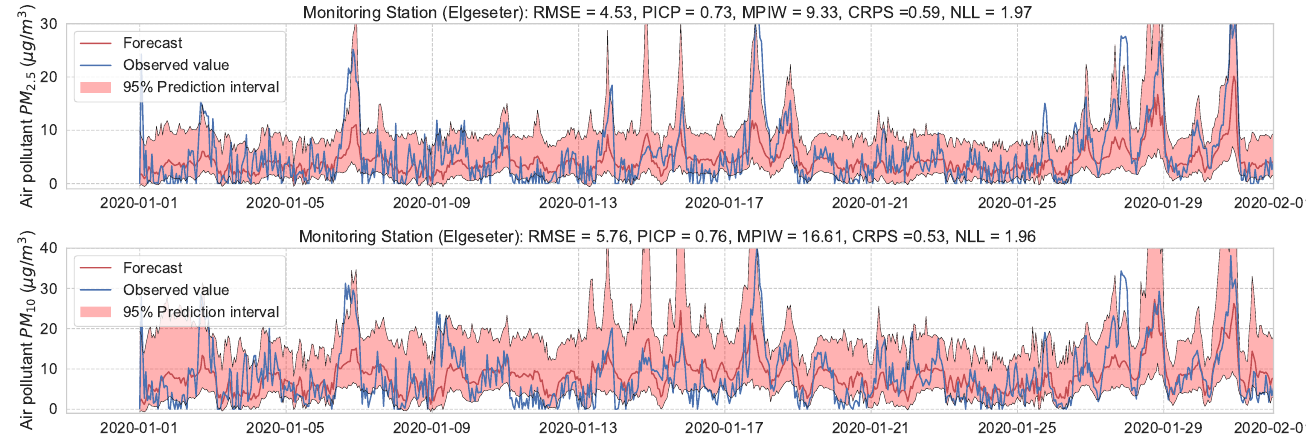
Figure 21. Probabilistic PM-value regression using a SWAG model.